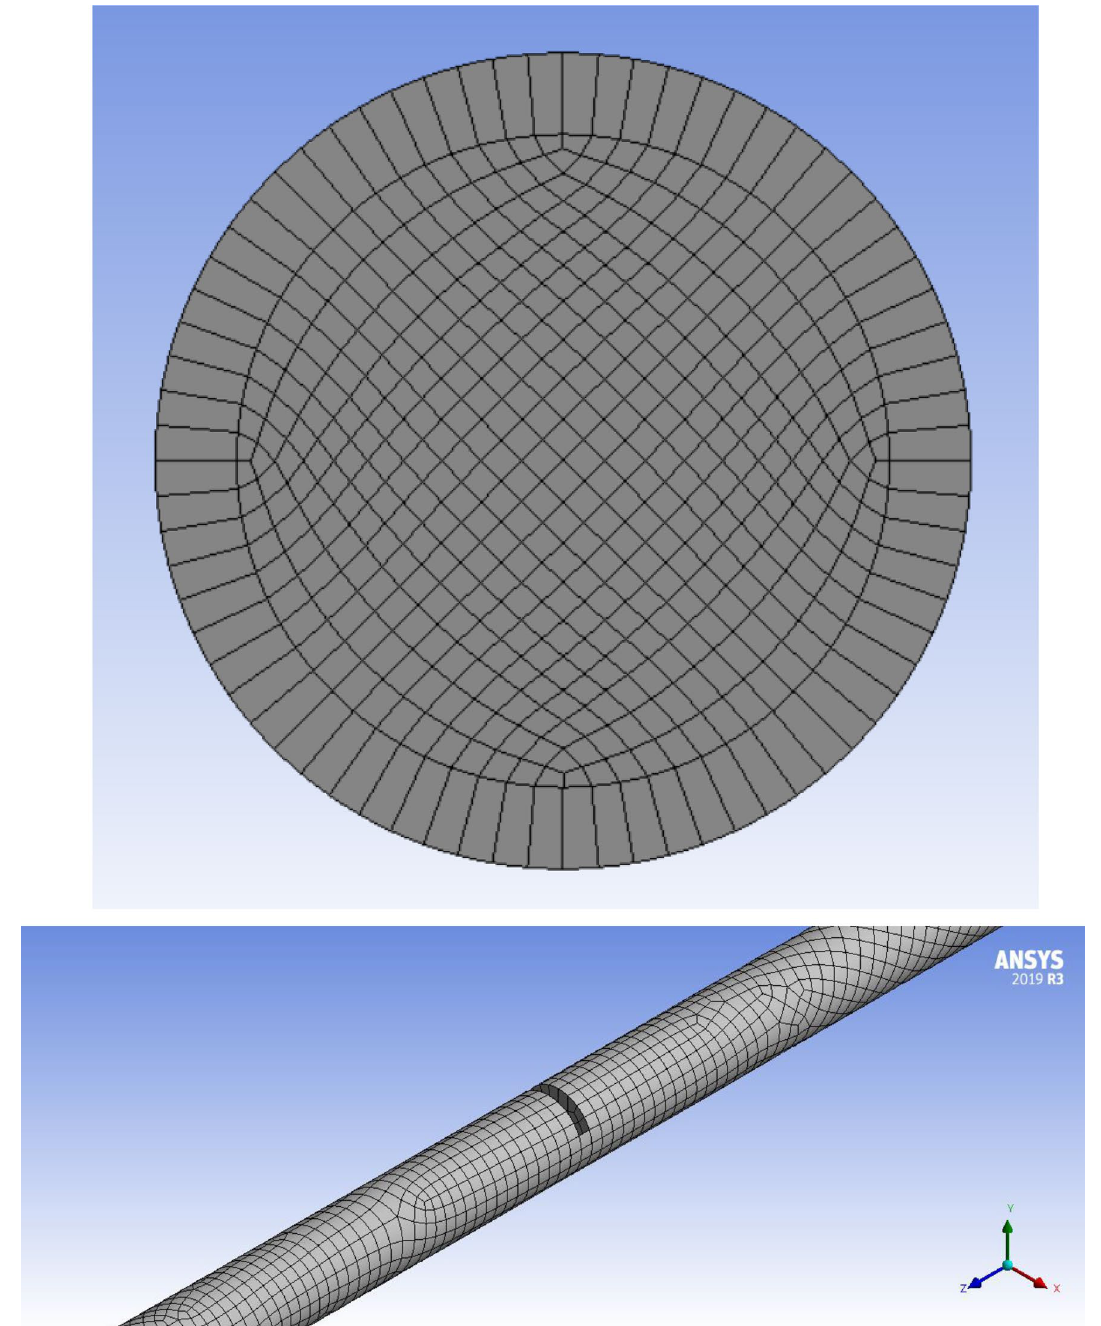
Fig. 9 Mesh Model of pipe with hexahedral element Table 1 Input parameters for all five cases of gate opening Rotation angle